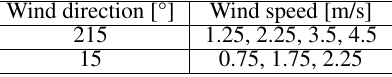
Table 1. Selected wind direction and